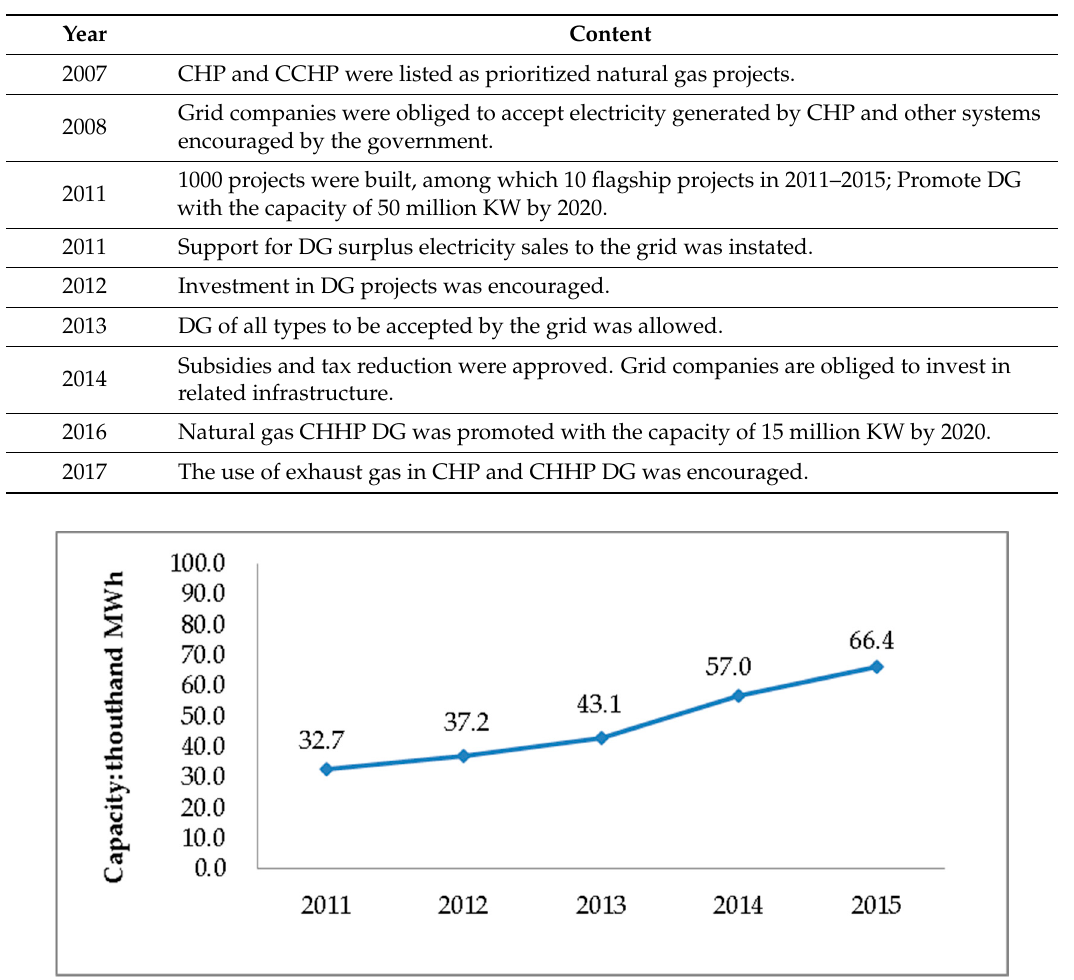
Table 1. Policies regarding natural gas distributed generation (DG) in China [6].